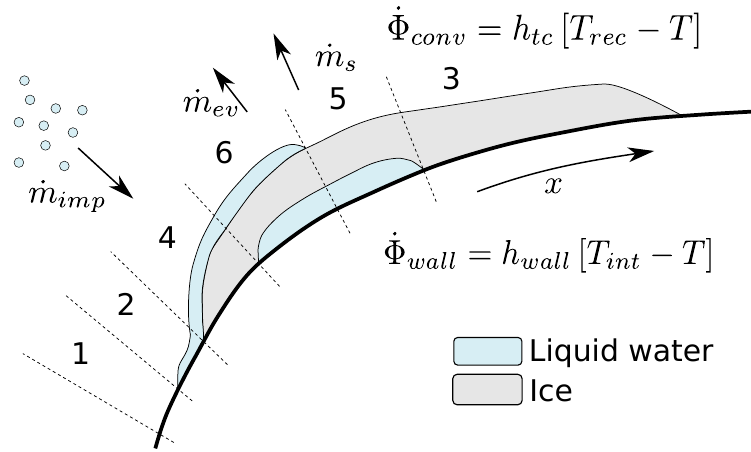
Figure 5. Illustration of a generic icing situation. Reprinted from [22], ©Elsevier.